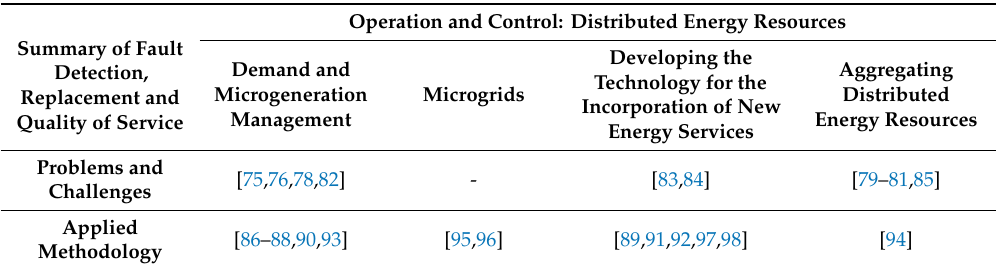
Table 4. Summary of Distributed Energy